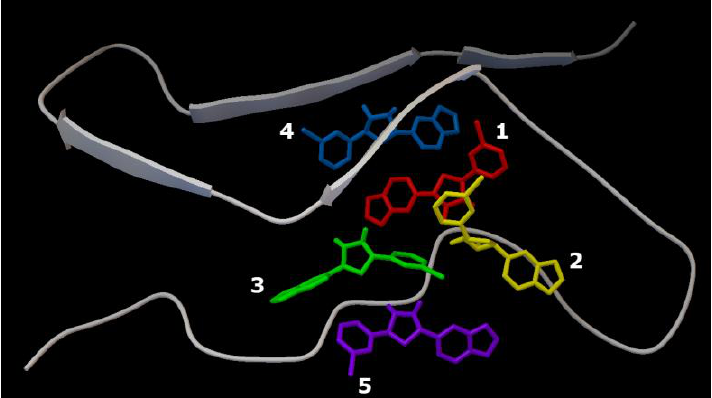
Figure 7. Five Anle138b ligand binding sites on a filament of AαSyn (PDB ID 7V4C). Individual Anle138b ligands are numbered: 1 — red, 2 — yellow, 3 — green, 4 — blue, 5 — violet. The close localization of binding sites in the target protein should be noted (region: His50 andThr72). The ligand molecules were oriented close to parallel stacking and were characterized by similar energy characteristics, −5 .7 kcal/mol to −6 .9 kcal/mol (Table 1). Table 1. Interactions of five Anle138b ligand molecules with a filament of AαSyn (PDB ID 7V4C). Interactions Residue AA Distance, Å Angle Ligand Atom Affinity (kcal/mol) First ligand 66A Val Hydrophobic